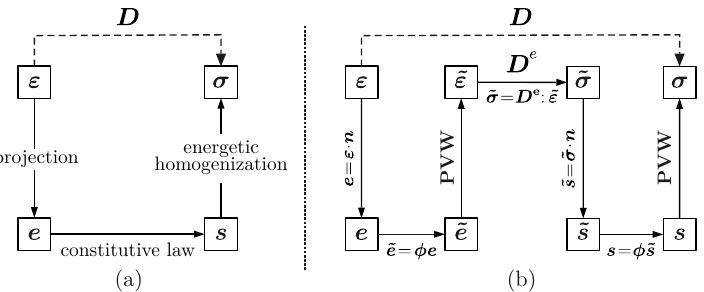
Figure 6. Algebraic structure of the microplane models ( a ) basic principle of microplane model; ( b ) constitutive stress–strain relation in the microplane damage